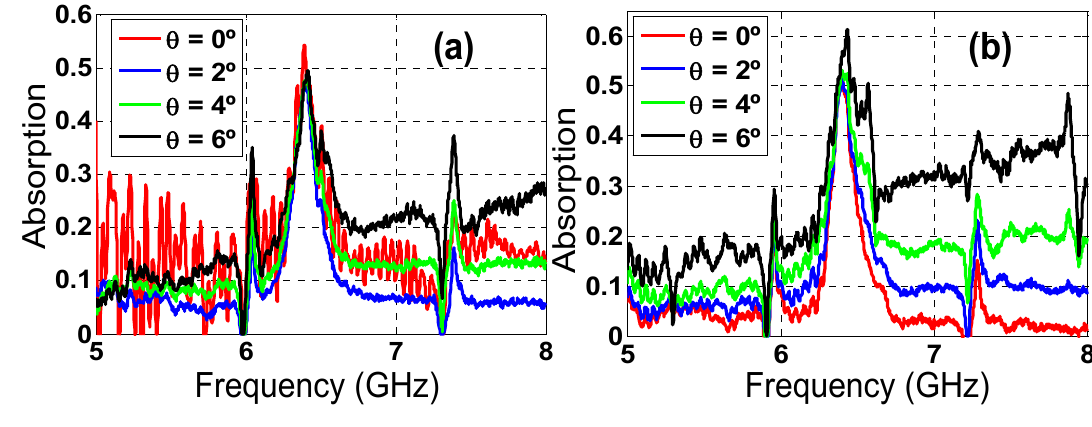
Figure 18. Star prototype measured absorption for different incident angles ( θ ) for both ( a ) TE and ( b ) TM